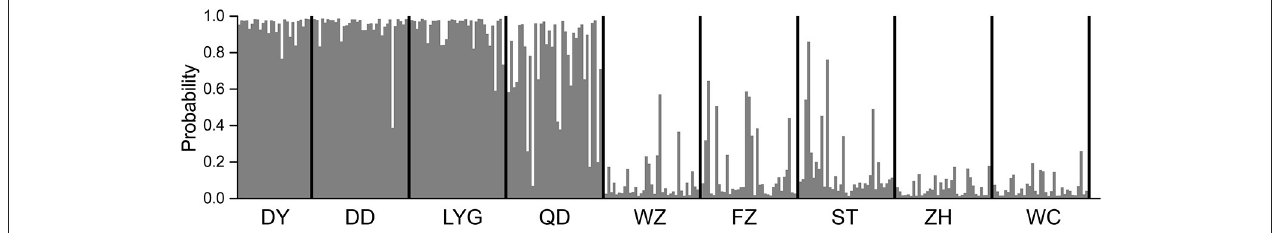
FIGURE 2 | Assignment of individuals based on the Bayesian clustering method by using STRUCTURE at K = 2. Each bar represents one individual of spinyhead croaker C. lucidus , with the estimated probability belonging to one or another population. Codes at the bottom indicate sampled estuaries (see Table 1 for